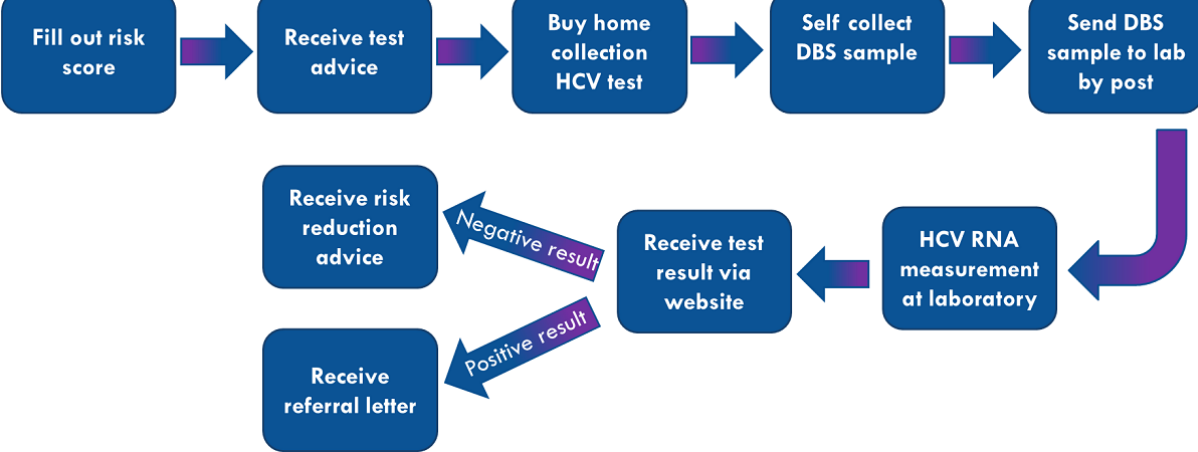
Face-to-Face Intervention